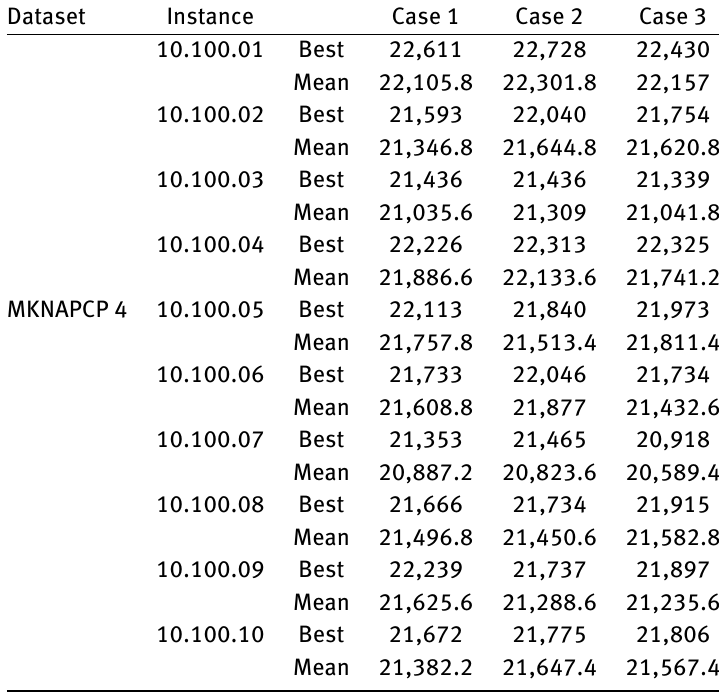
Table 7: Experimental results on effect of Crossover Rate on MKNAPCP 4 instances